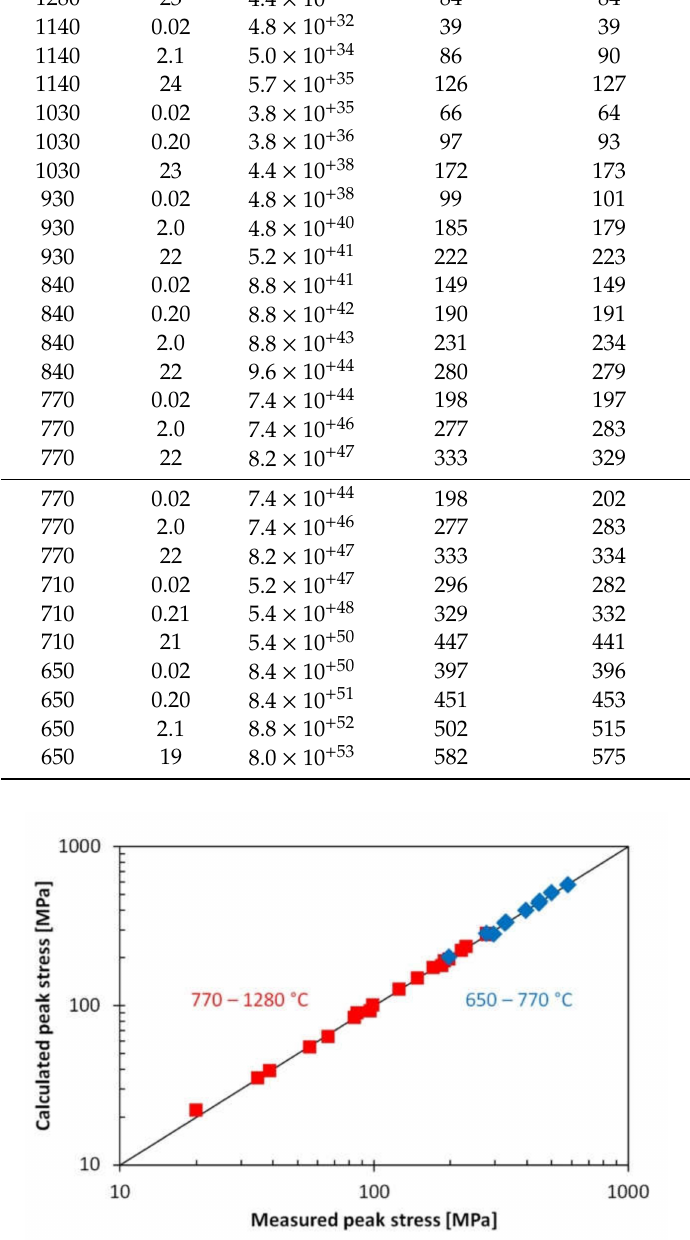
Figure 17. Accuracy of the values σ p –values prediction according to Equation (5) (red points) and Equation (6) (blue